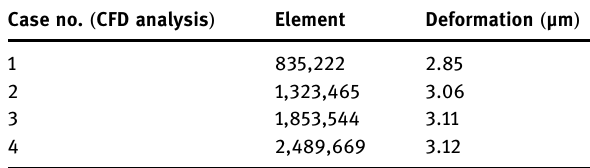
Table 2: Mesh independence Case no. ( CFD analysis